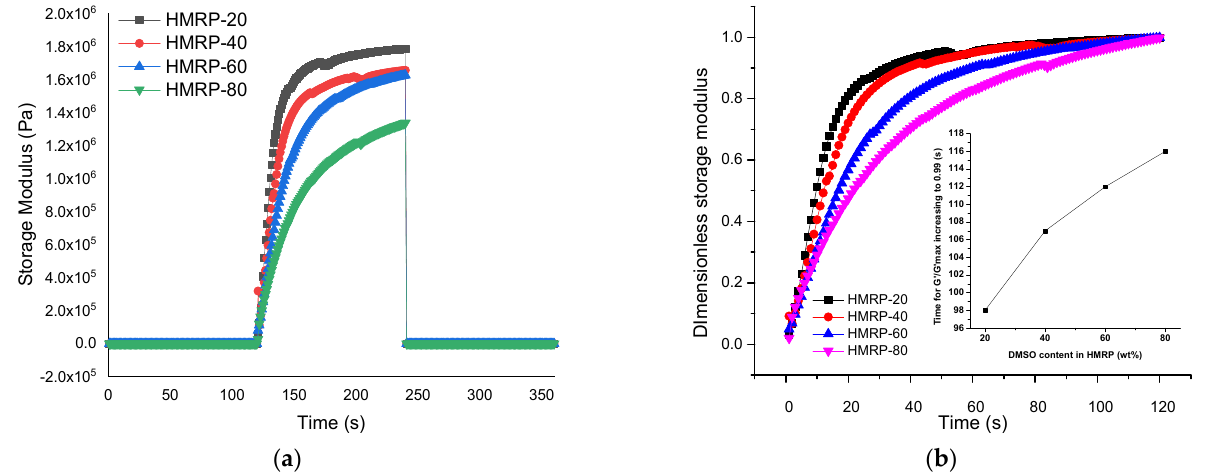
Figure 5. Time dependence of G ′ for PVA-based MRP with different solvent ratios in response to a stepwise magnetic field ( a ) and the dimensionless transient response of G ′ ( b ) under a magnetic field of 500 mT.